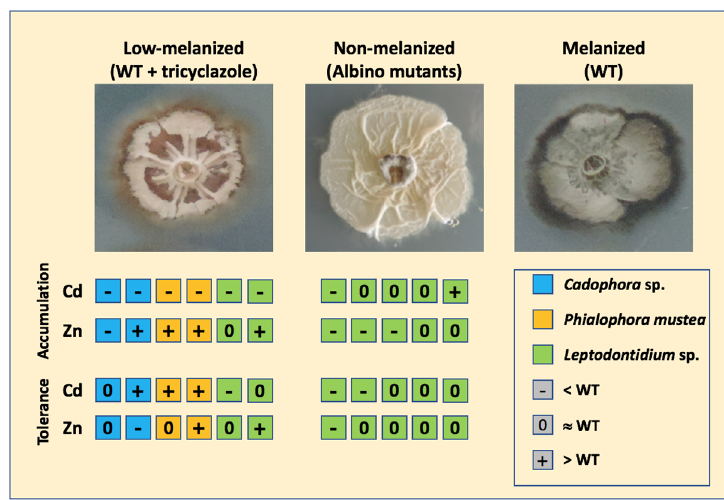
Figure 7. Summary of metal accumulation and tolerance as a function of melanization in DSEs. Both Cd and Zn accumulation and tolerance levels of the tricyclazole-treated and albino strains are shown relatively to those of the wild-type strain. Each square denotes a given strain. Tricyclazole was used to inhibit DHN-melanin, the major form of melanin of the three DSE species.